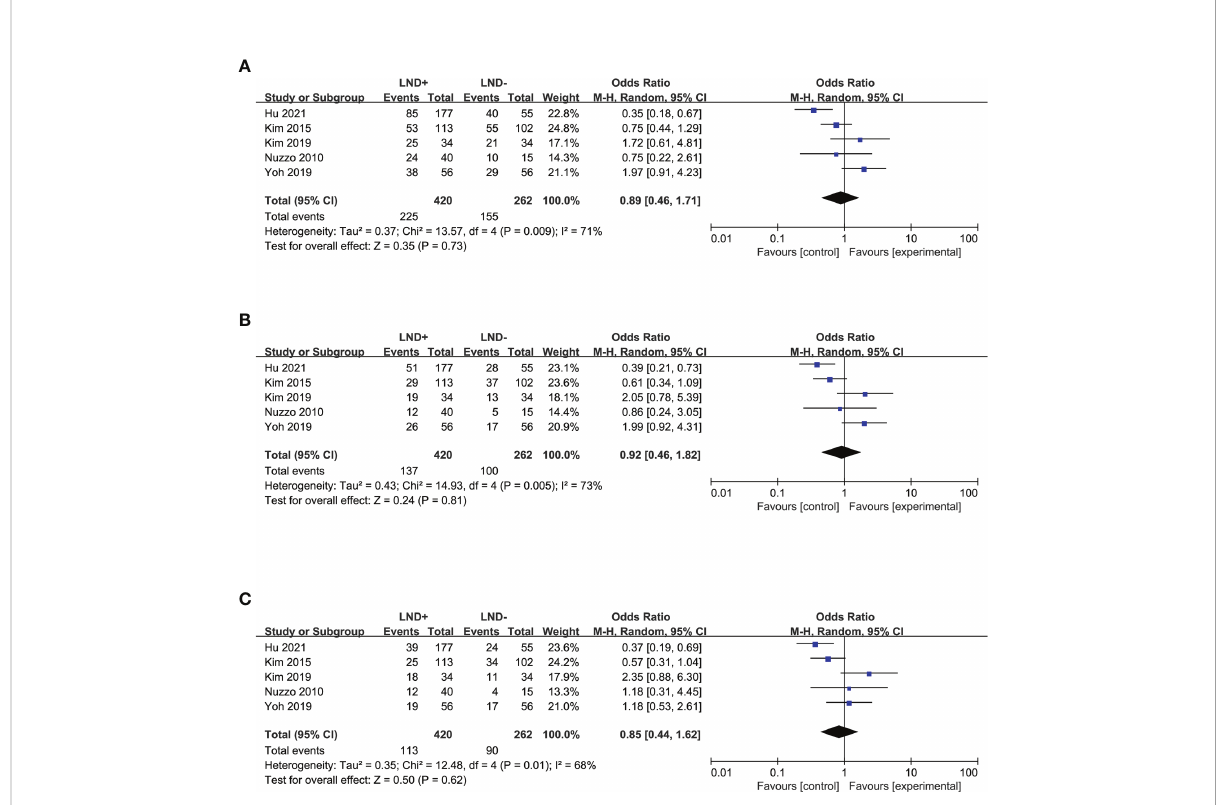
FIGURE 3 Forest plot comparing disease-free survival in LND+ and LND − groups. (A) 1-year DFS; (B) 3-year DFS; (C) 5-year